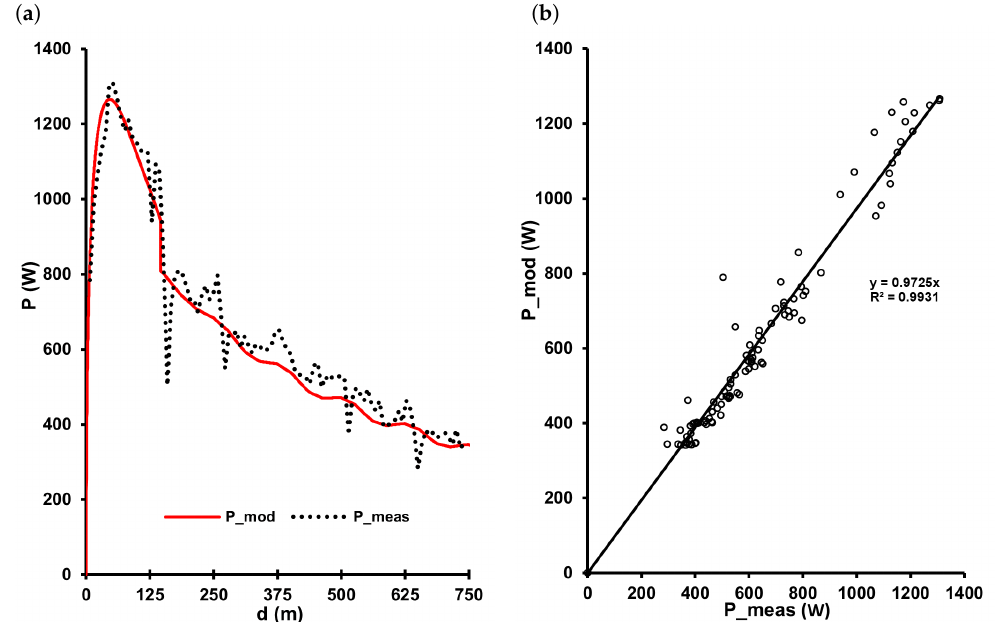
Figure 6. Comparison of measured and modelled mechanical power output in the first run of a 750 m-time trial. ( a ) Measured and modelled data ( b ) linear regression